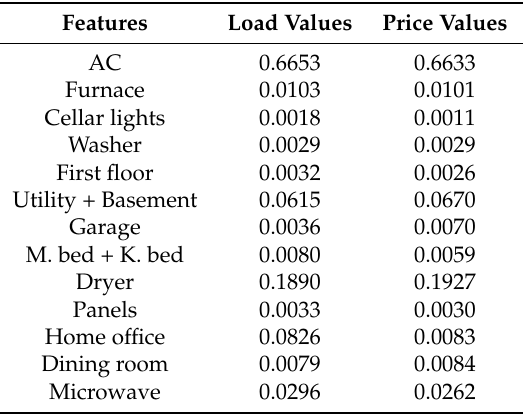
Table 6. Results of CART for UMass Electric